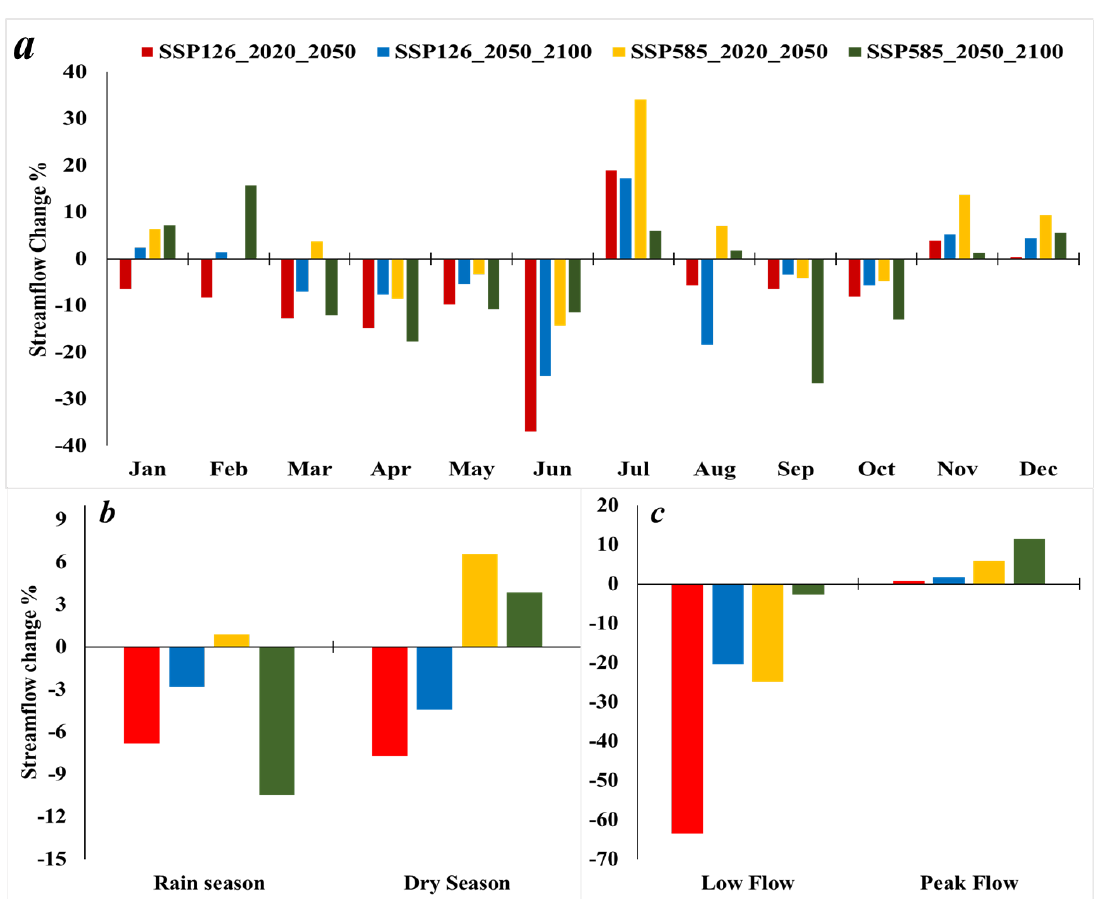
Figure 7. Relative streamflow changes: ( a ) monthly, ( b ) seasonal, and ( c ) in low and peak flow.